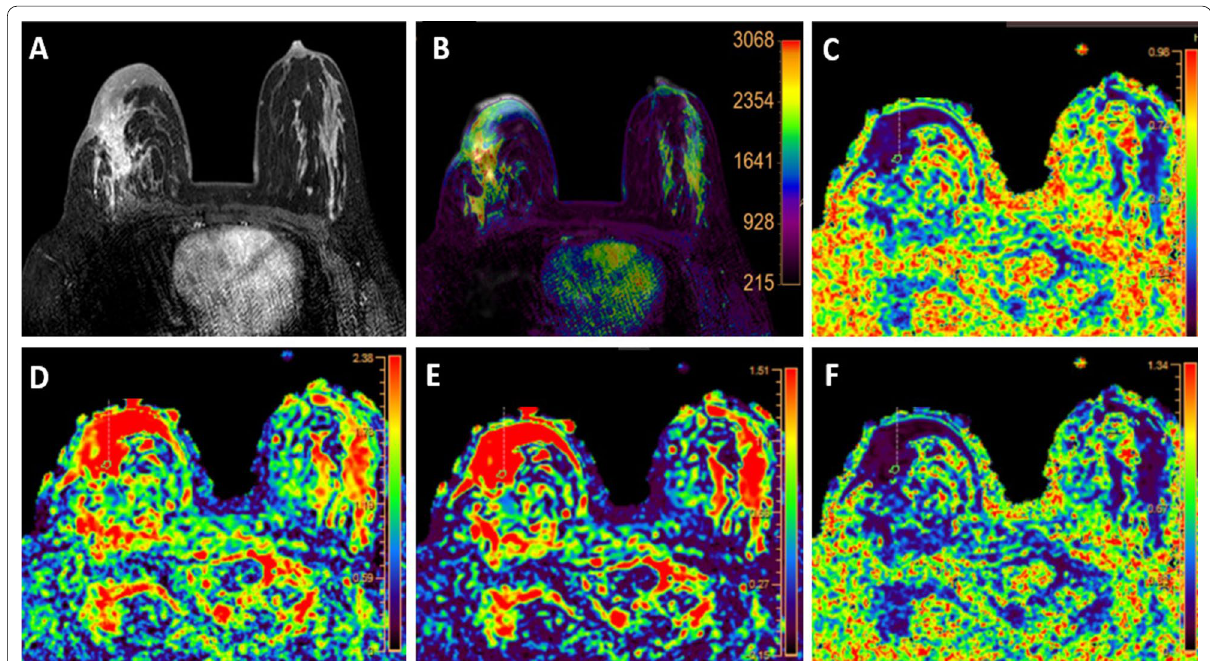
Fig. 2 A 39‑year‑old patient with a history of right BCT 9 months ago for grade II IDC. A DCE‑MRI shows regional heterogeneous NME in the upper outer quadrant of the right breast. B Fused DCE‑MRI and DTI images used for ROI placement. Parametric color maps of DTI C FA, D AD, E RD, and F RA were generated and analyzed. ROI is placed within the lesion borders to calculate all the DTI parameters. MD AD